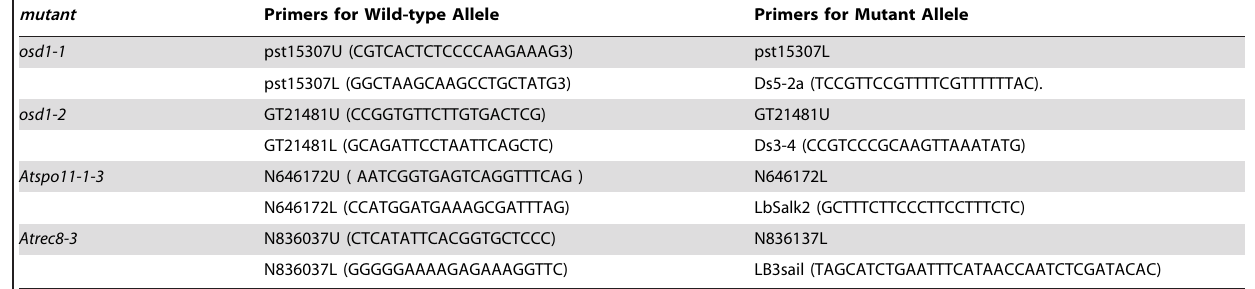
Table 1. Primers for mutant genotyping.